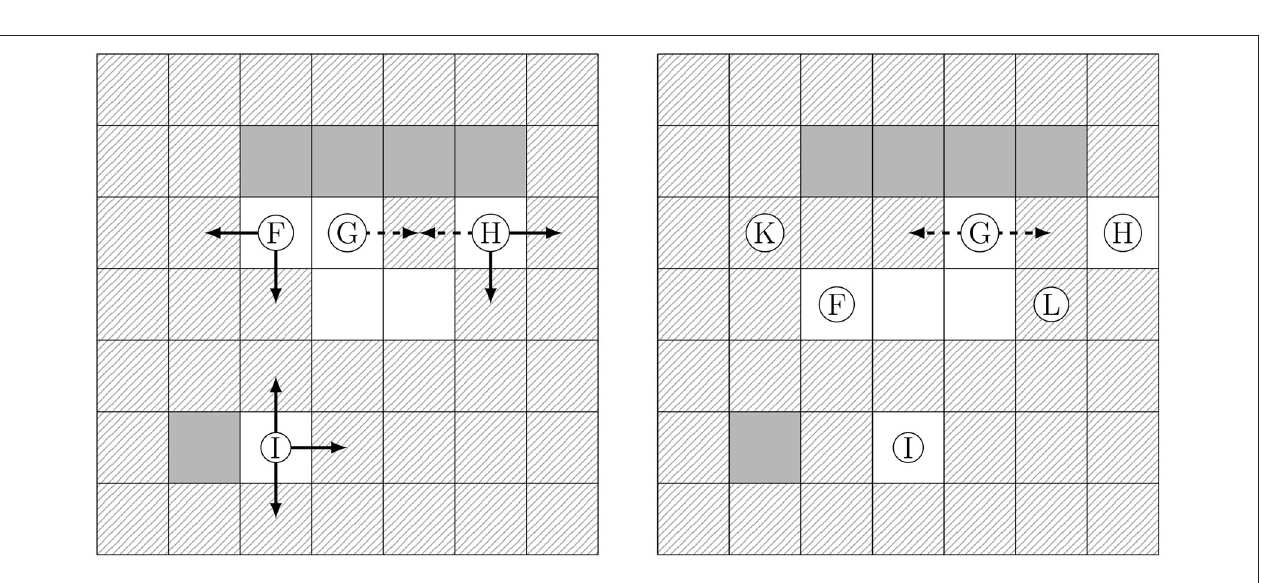
FIGURE 5 | Reorganization of gas cells being tangent to solid cells. (Left) Favorable options (continuous arrows) leading to a loss of contact to solid, and further options (dashed arrows) having the same contact to solid. (Right) The cells F , H , I performed a favorable step, and G moved also (dashed step). G will repeatedly change positions tangent to the solid (equally favorable, dashed steps) until finally position K or L can be reached (by a favorable